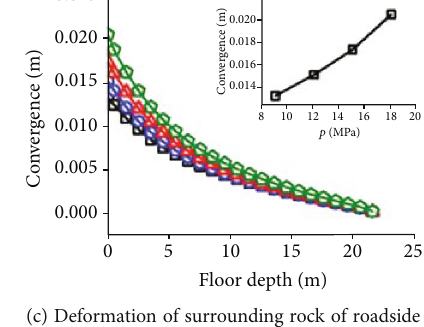
Figure 11: The convergence of roadway surrounding rock under various spherical